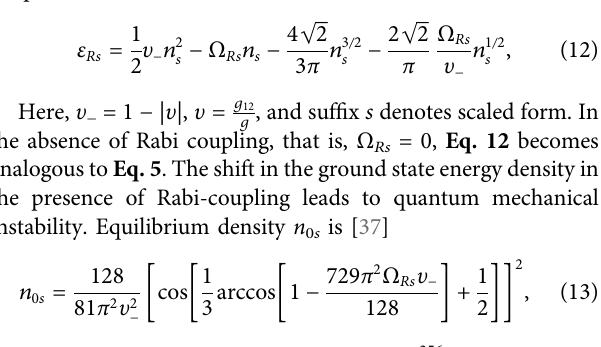
The mixture is stable for 0 < Ω Rs υ − ≤ 256 Figure 4A . The white band shows instability at | υ |~